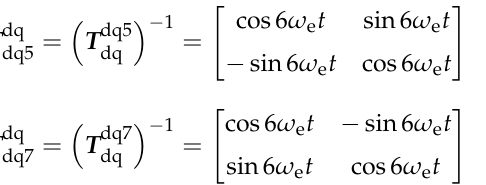
It can be seen from Figure 3 that this PI based current harmonic controller uses multiple PI, so the parameter tuning is complicated and the coupling effect between the dq axis is ignored. Which will affect the suppression effect of current harmonics. In order to avoid this problem, some scholars replace the PI controller with deadbeat predictive control (DPC). The control block diagram is shown in Figure 4.